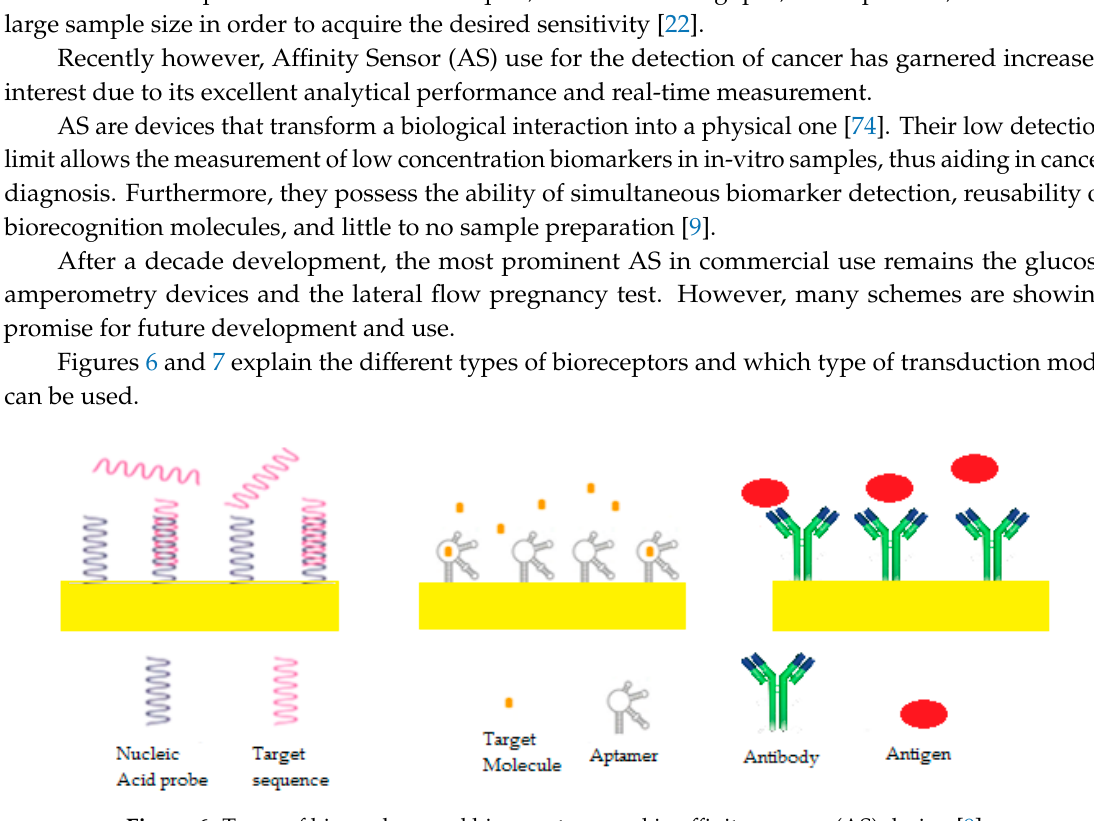
Figure 6. Types of biomarkers and bioreceptors used in affinity sensors (AS) design [9].